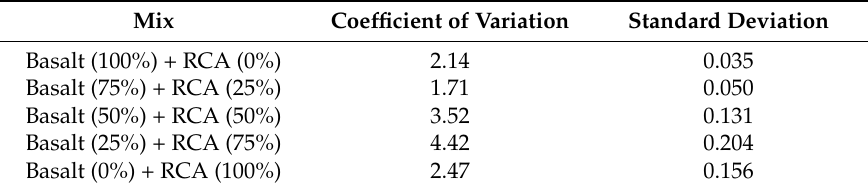
Table 12. Coefficient of Variation and Standard Deviation for Mix of Coarse